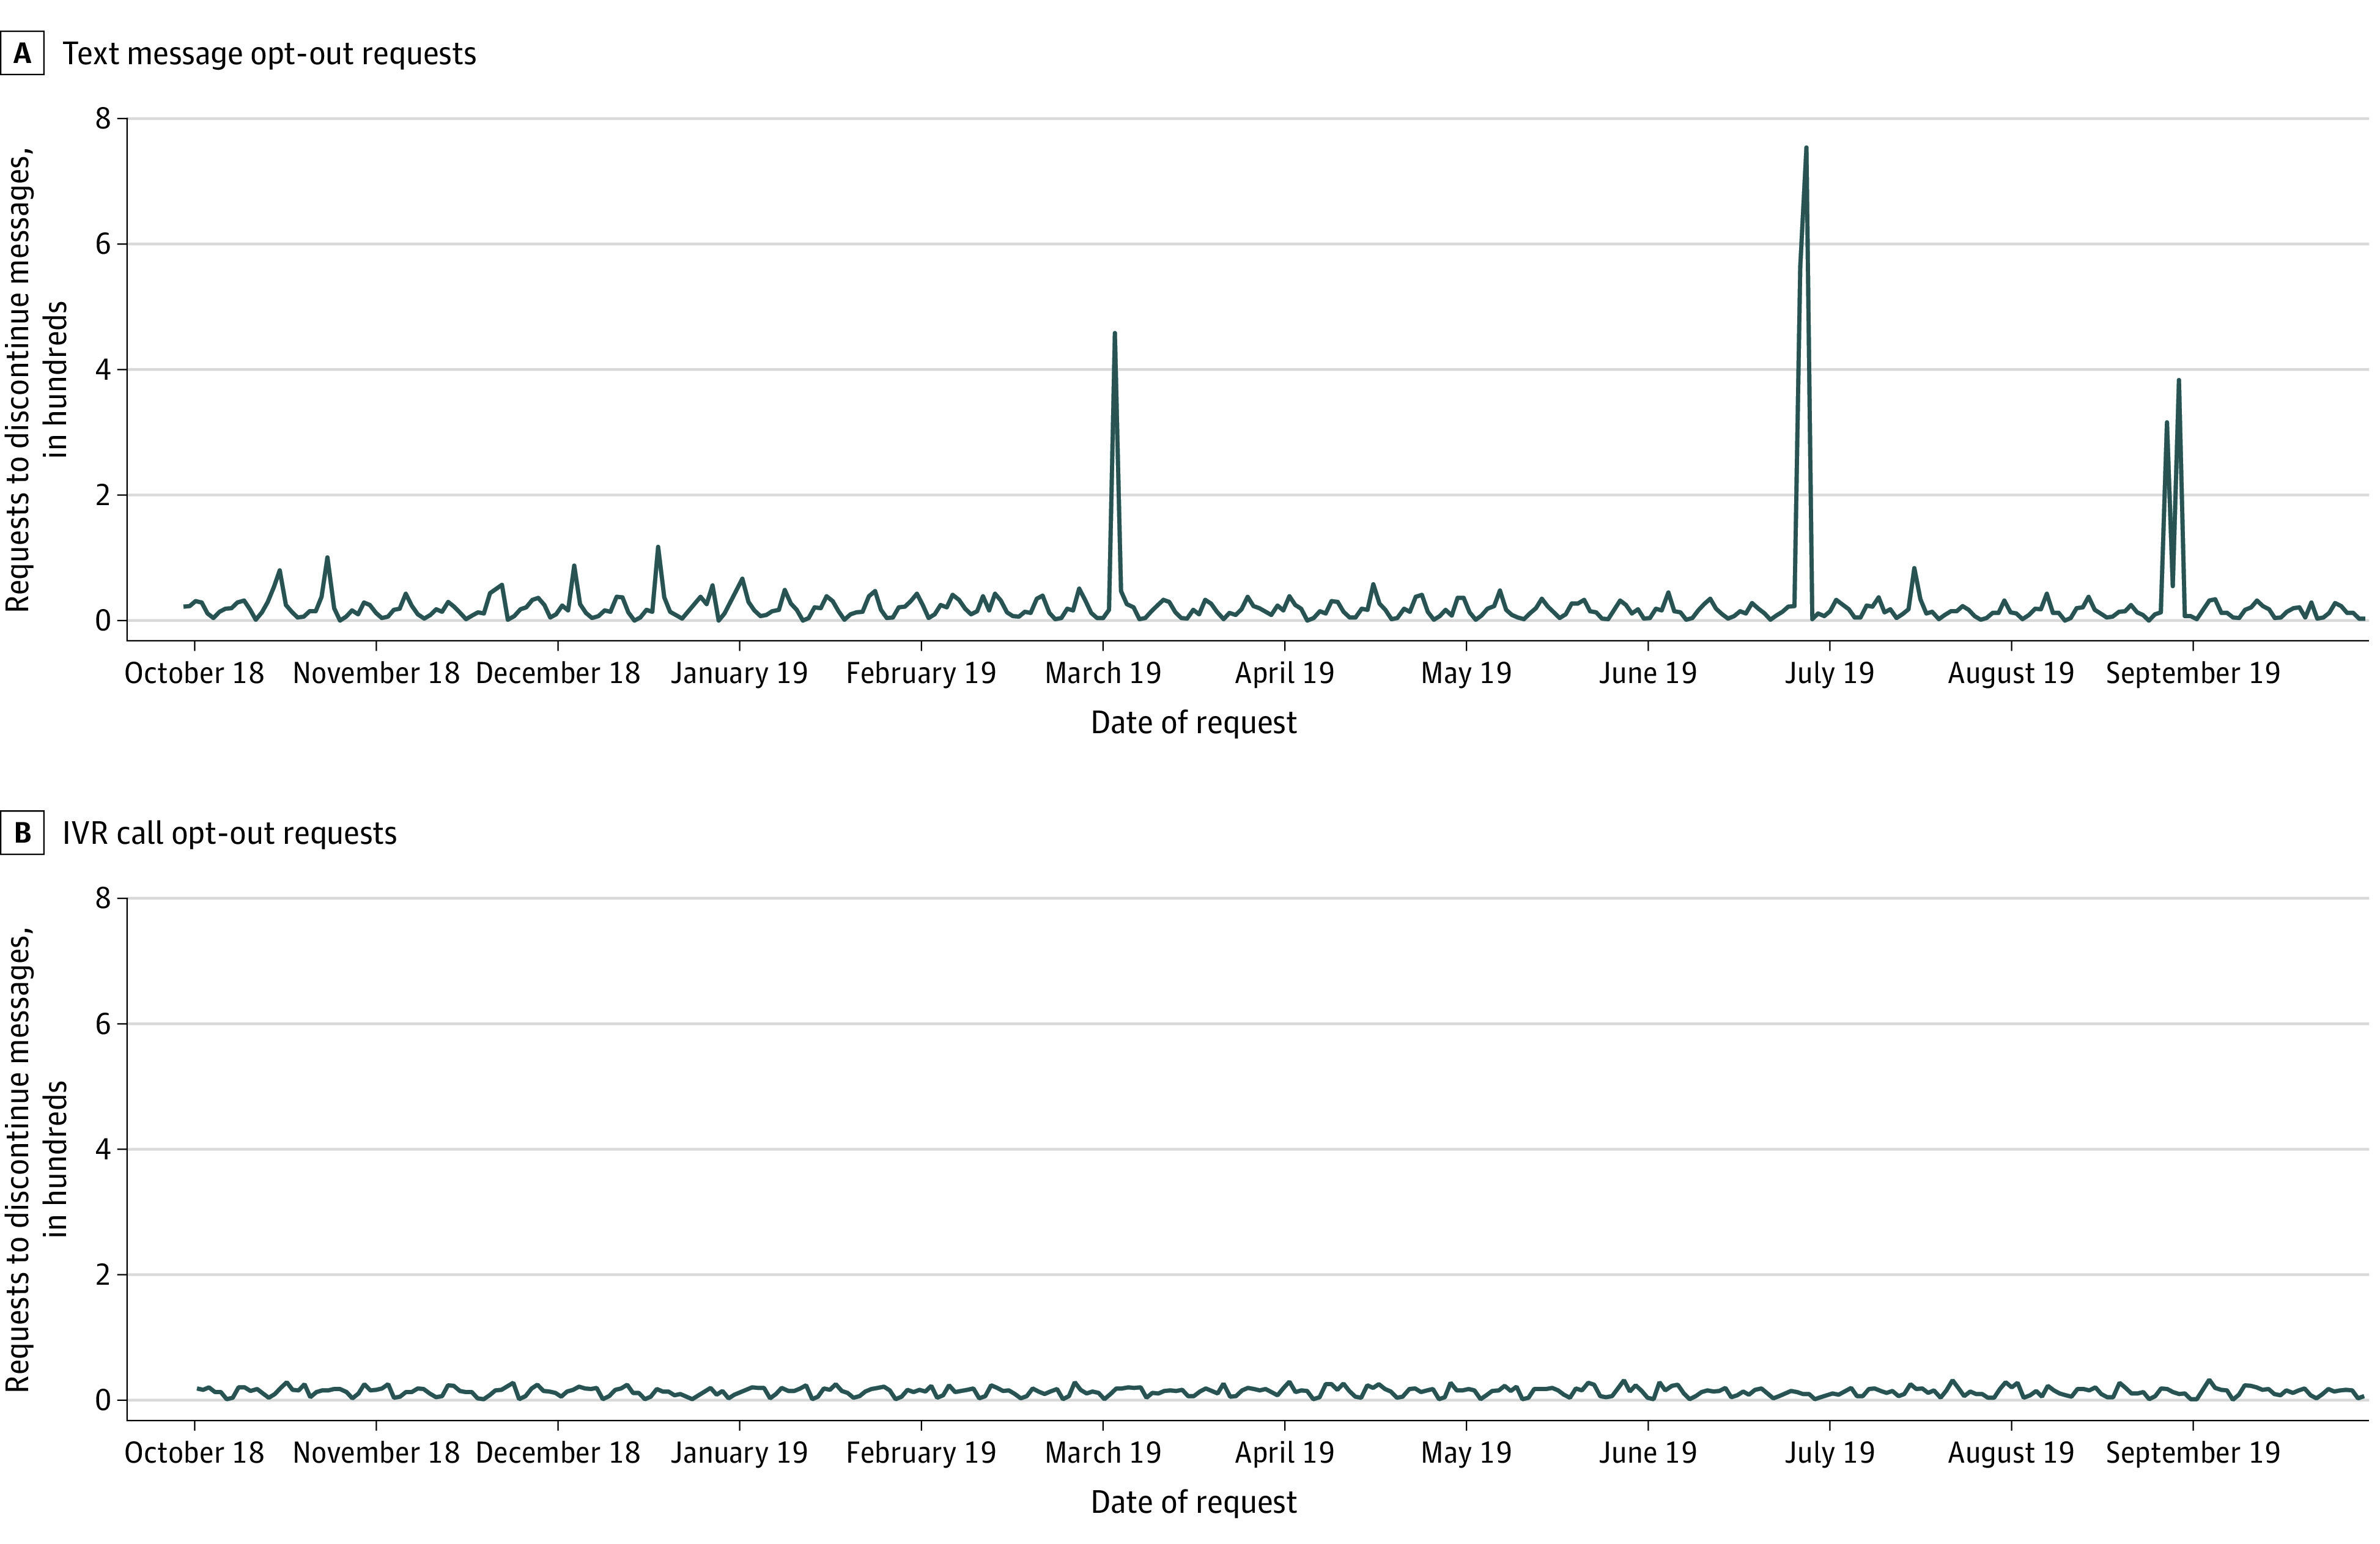
Requests to Opt Out of Automated Text and Interactive Voice Response Messages by Week From October 1, 2018, to September 30, 2019Three spikes in requests followed messages delivered to large numbers of Kaiser Permanente Colorado members.